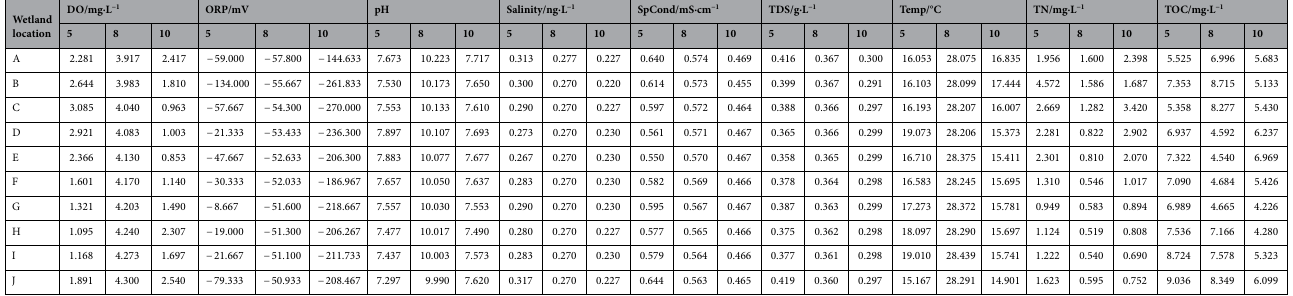
Table 1. Physicochemical characteristics of the surface-flow constructed wetlands in each unit. (5: May; 8: August; 10: